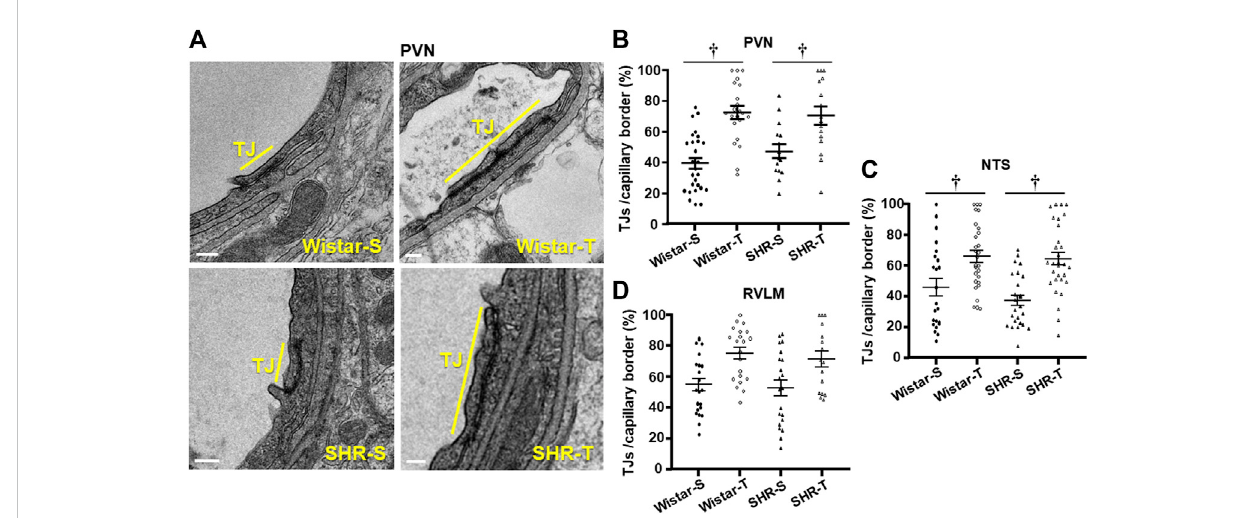
FIGURE 4 Effects of hypertension and exercise training on tight junction (TJ) occupancy of capillary border. (A) . Electron micrographs depicting TJ extension (yellowbars)intheborderofneighboringendothelialcellswithinPVNcapillariesofsedentary(S)andtrained(T)SHRandWistarrats.Scalebars=200 nm. Right panels show the quanti fi cation of TJ extension in the 4 experimental groups at the end of protocols within the PVN (B) , NTS (C) , and RVLM (D) capillaries. n = 5 – 7 capillaries/rat, 3 rats/group. Comparisons made by 2-way factorial ANOVA. Signi fi cance ( p < 0.05) is † vs. respective S control.